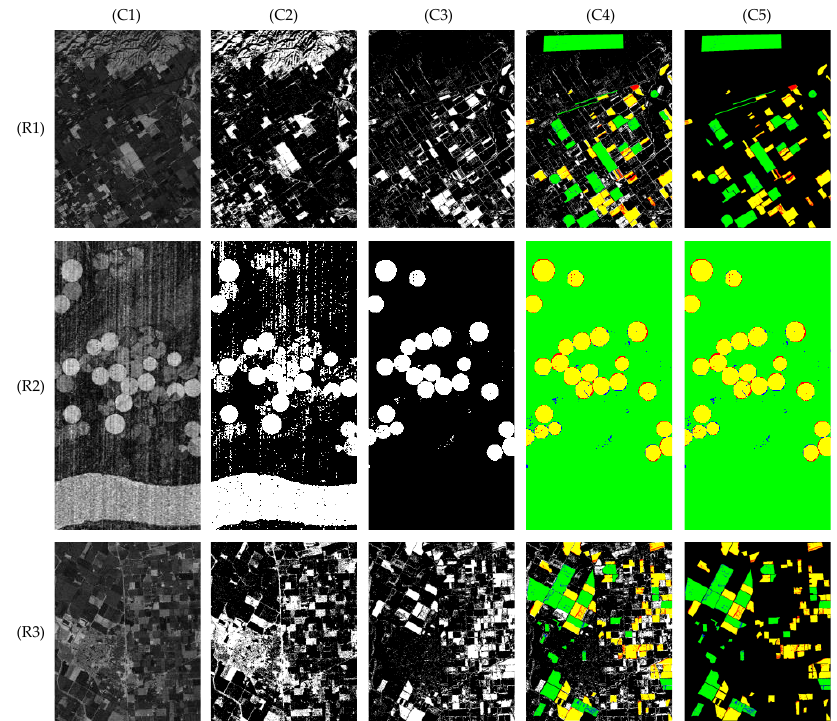
Figure 8. Re-estimation of argument regions using AL. ( R1 ) ‘Santa Barbara’, ( R2 ) ‘Hermiston’,